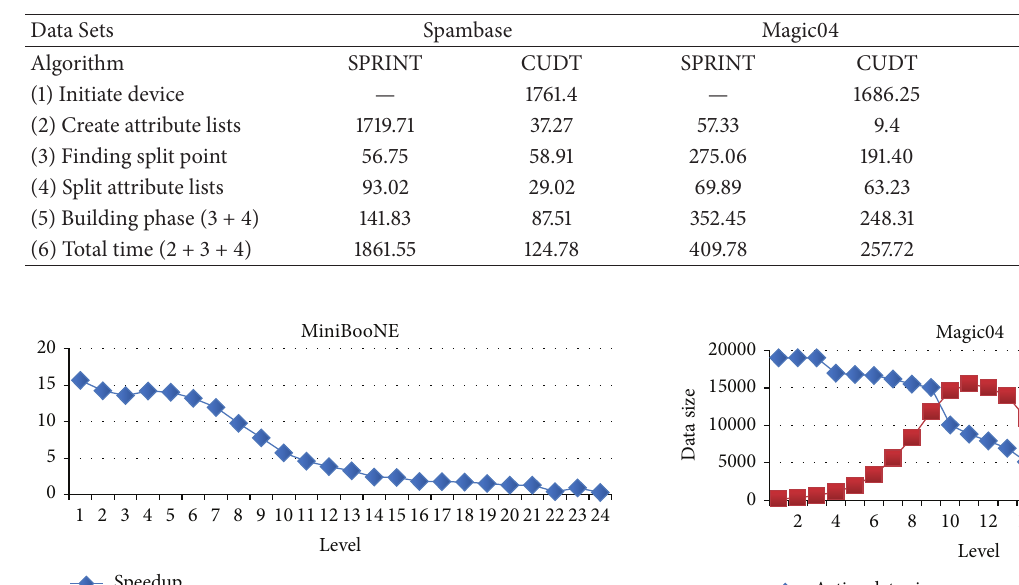
Table 5: Comparison of SPRINT and CUDT.